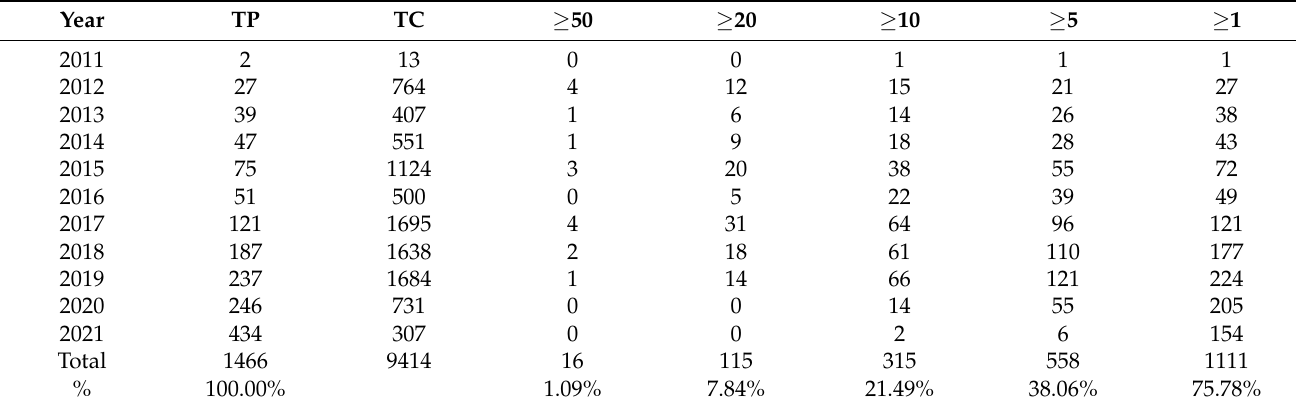
Table 1. Annual publication and citation structure.